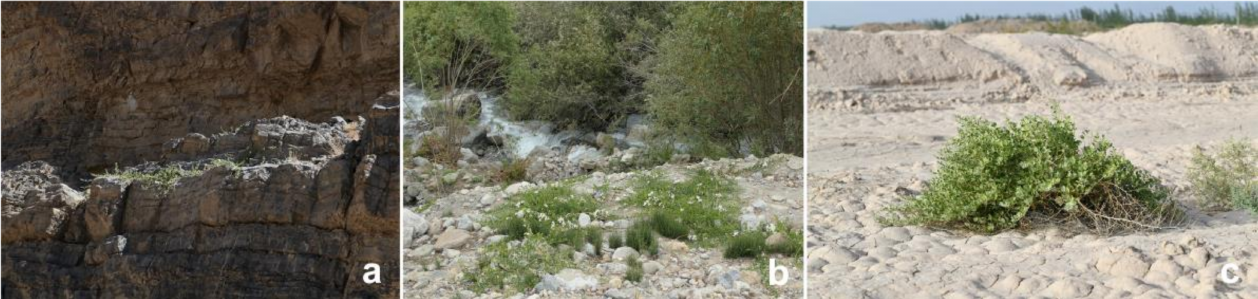
Figure 1. Different habitat requirements of C. spinosa : ( a ) high-altitudinal desert plateau, ( b ) medium- altitudinal valleys and ( c ) low-altitudinal desert